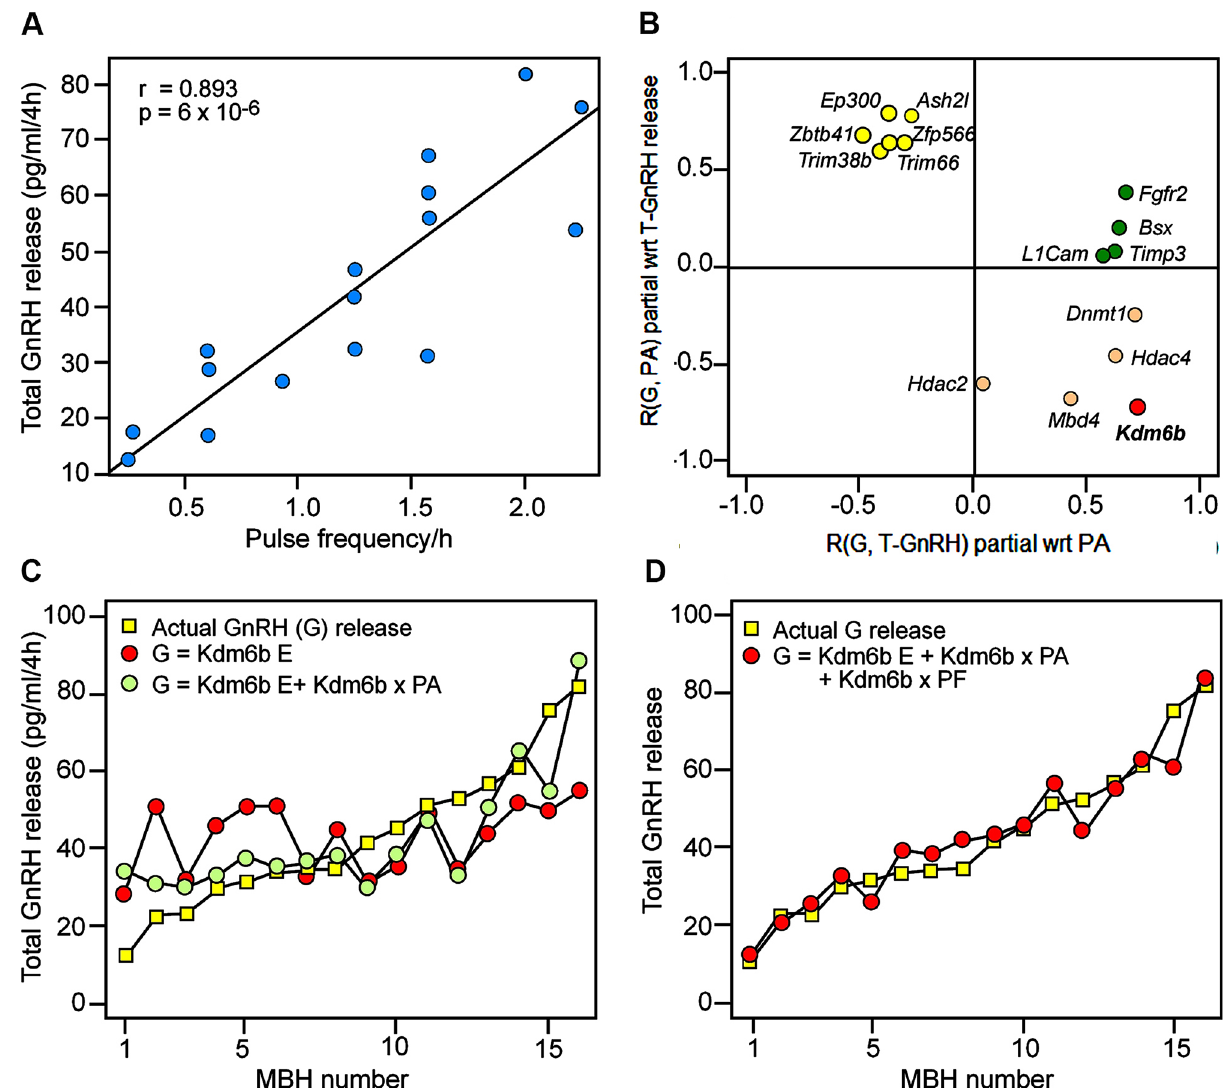
Figure 2. Correlations between gene expression and GnRH release from the MBH after EED overexpression. ( A ) Scatterplot of total GnRH release vs. average GnRH pulse frequency/hour over a 4 h incubation period of MBH fragments derived from late juvenile 28-day-old female rats injected 6 days earlier with a lentiviral expressing GFP alone (n = 8) or EED plus GFP (n = 8). Best- fit linear correlation is indicated by black line. ( B ) Plot of partial correlations (R) of gene expression (G) as assayed by OpenArray/qPCR with total (T) GnRH release and pulse amplitude (PA) with regard to (wrt) other physiological metric. ( C ) Plot of total GnRH release ordered from lowest to highest (yellow squares) and regression model predictions for Y ̂ Total Expression = β intercept + β Kdm6b expression (red circles) and Y ̂ Total Expression = β intercept + β Kdm6b expression + β Kdm6b expression x Pulse Amplitude(PA) (green circles). MBH number refers to one of the 16 MBH incubated in vitro. ( D ) Plot of total GnRH release ordered from lowest to highest (yellow squares) and regression model prediction for Y ̂ Total Expression = β intercept + β Kdm6b expression + β Kdm6b expression × Pulse Amplitude (PA) + β Kdm6b expression × Pulse Amplitude (PA) × Pulse Frequency(PF) (red